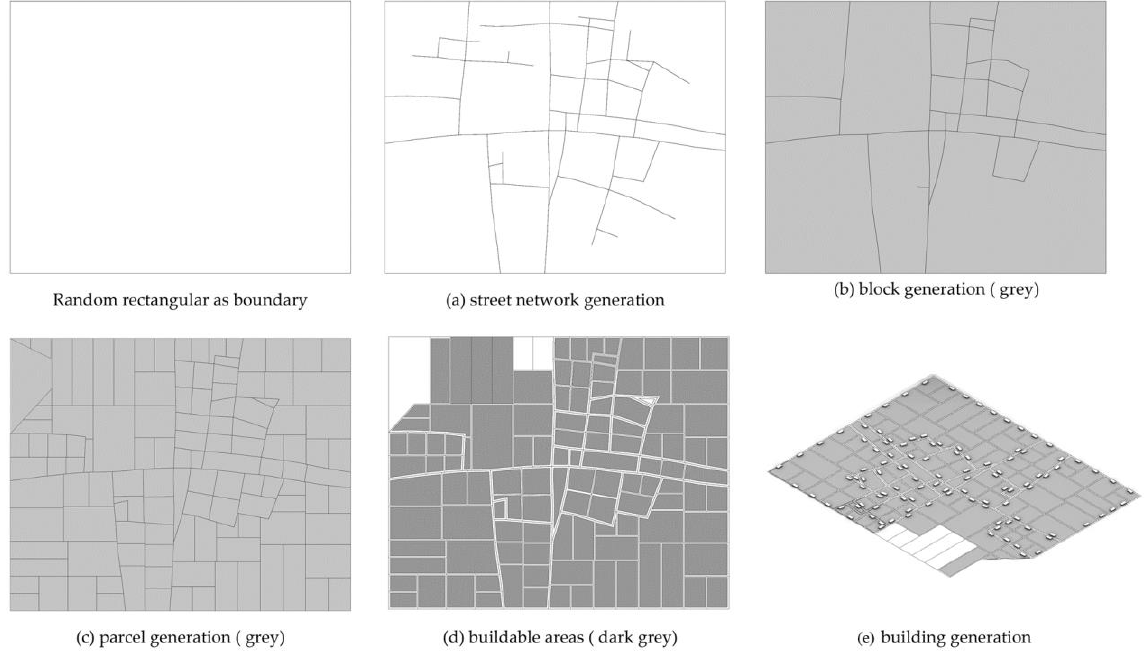
Figure 4. The results of each step in the generative design process (with random rectangle as bound- ary and default input parameters). and default input